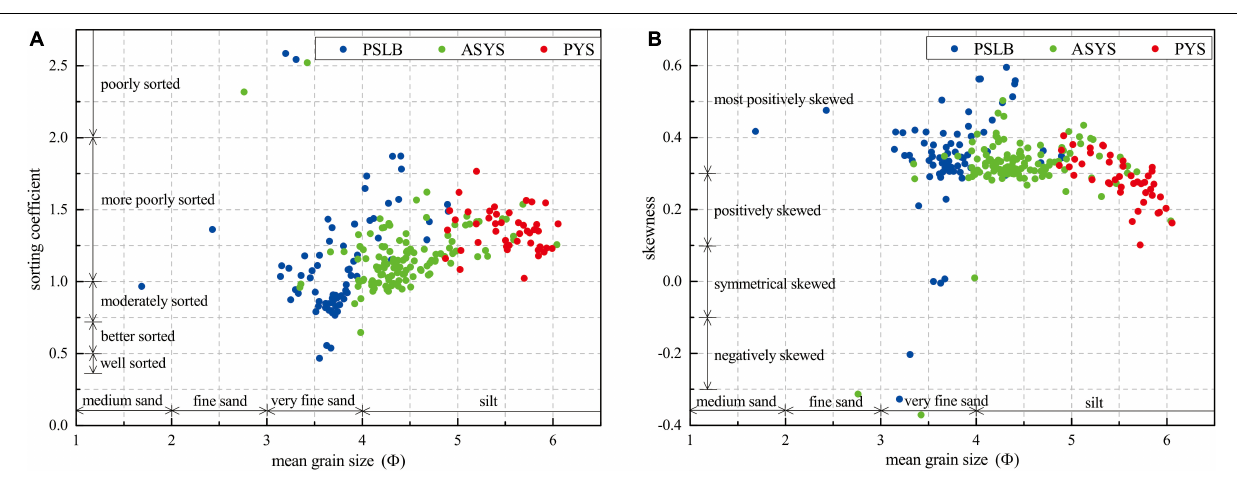
Frontiers in Marine Science |